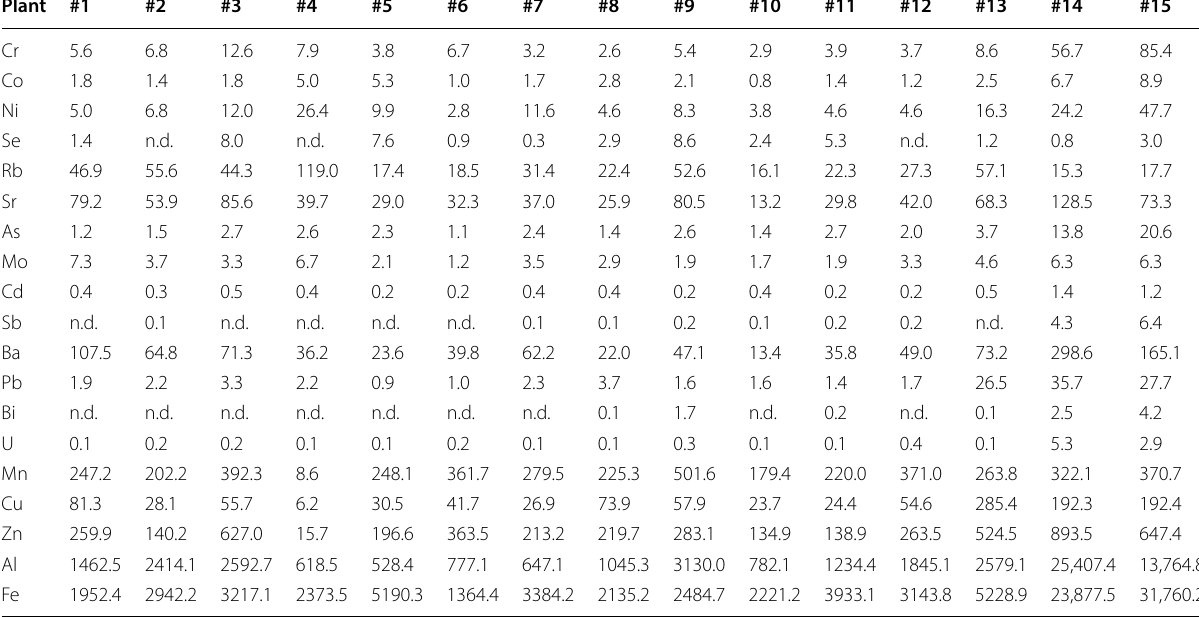
Table 2 Metal(loid) concentrations found in the investigated plants, normalized to the slurries dry weight [units: mg kg − 1 dry